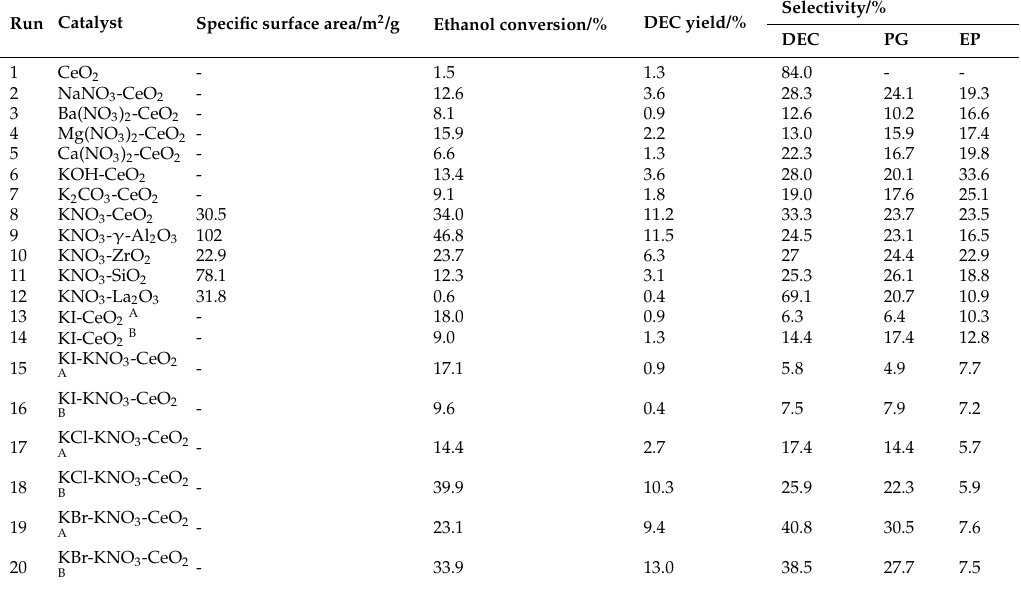
Table 1. Effects of different catalysts on the one-pot reaction. DEC, diethyl carbonate;